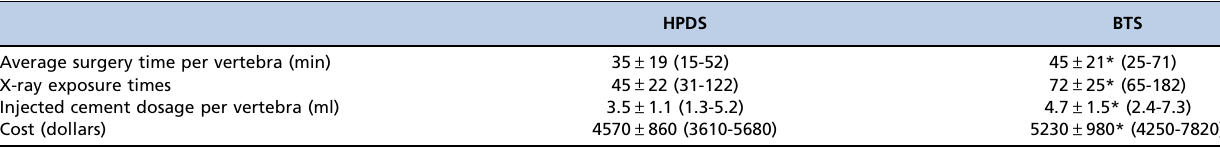
Table 2 - Surgery parameters (mean ± SD,